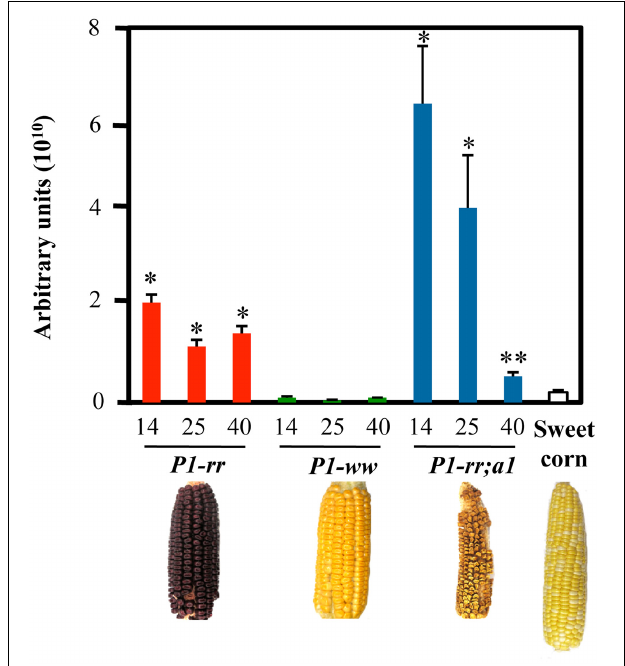
FIGURE 2 | Higher flavonoid levels in P1 expressing lines. HPLC analyses of pericarps at 14, 25, and 40 DAP. Total flavonoid levels are indicated as arbitrary units (mean values ± s.e.m., n = 5 for all maize lines and n = 3 for P1-rr;a1 ). t -test ∗ p < 0 . 01 or ∗∗ p < 0 . 05 compared to sweet corn. Arbitrary units correspond to total peak area at 350nm per g of dry